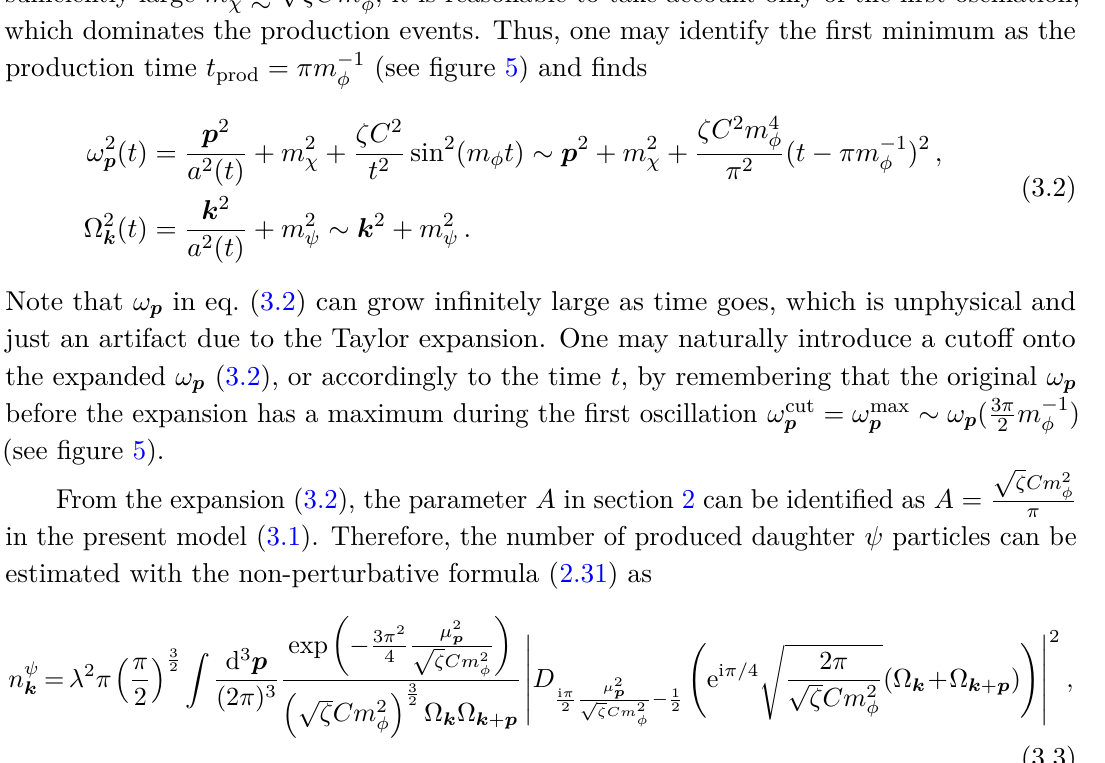
< Ω k + Ω k + p < ω max (namely, if p p (i.e. Ω k +Ω k + p p